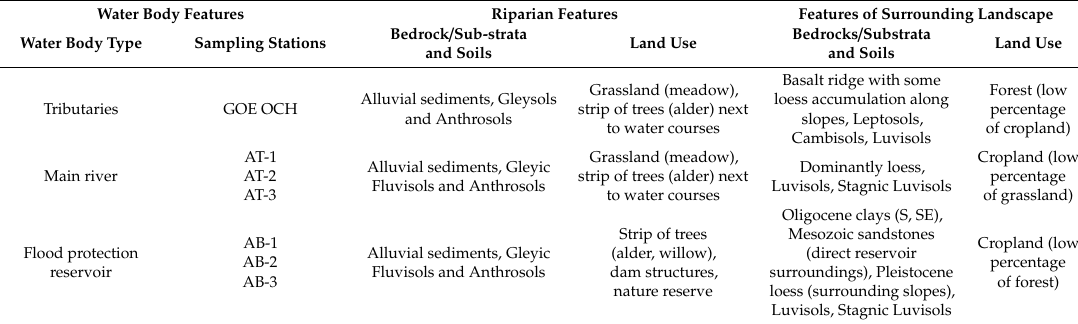
Table 1. Environmental characterization of the Antrift